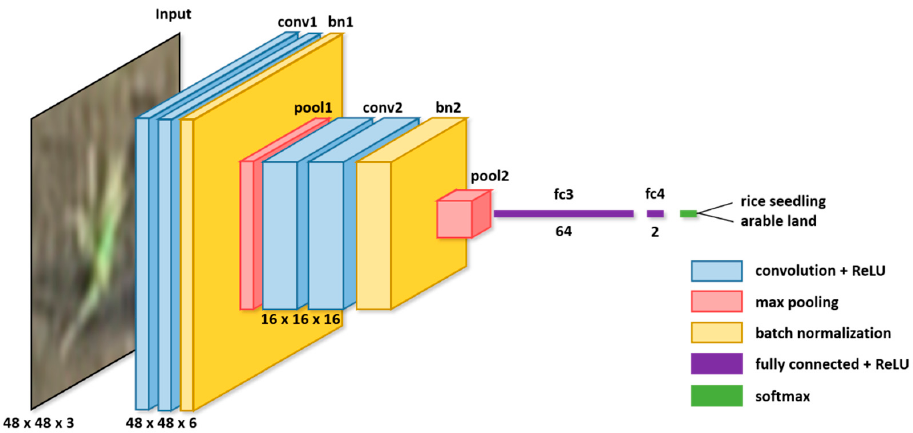
Figure 7. Subset 7 was clipped from the orthomosaic image. (The spotlighted image is enhanced in contrast for a clearer view, not in true color).